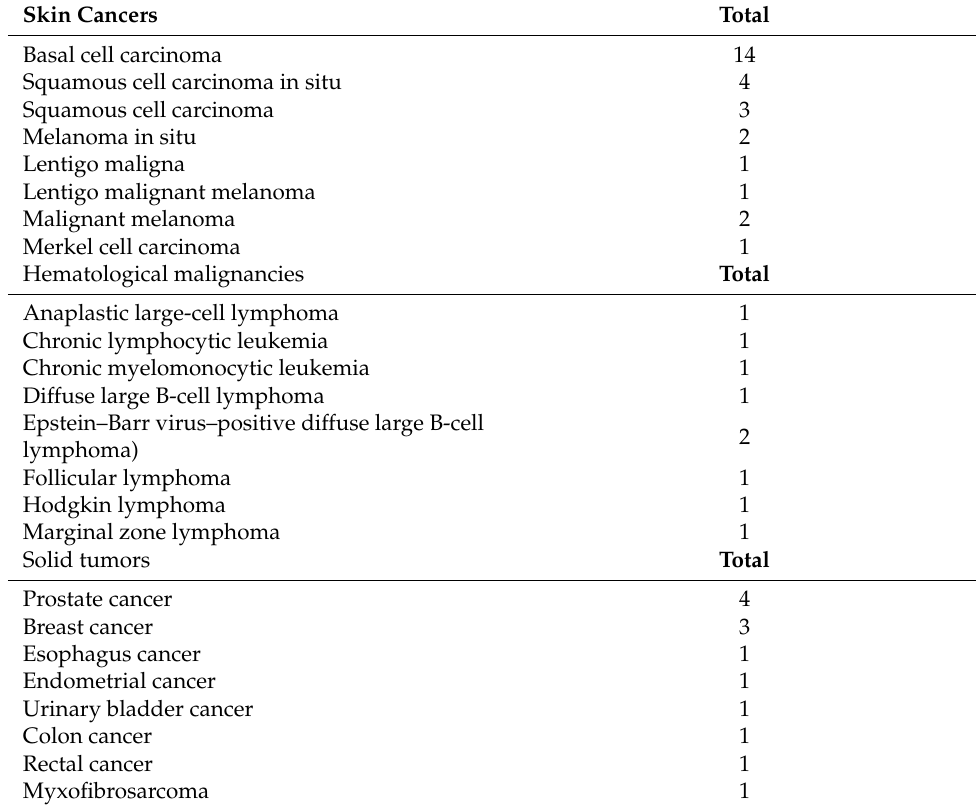
Table 2. Summary of malignant comorbidities in 25 patients with mycosis